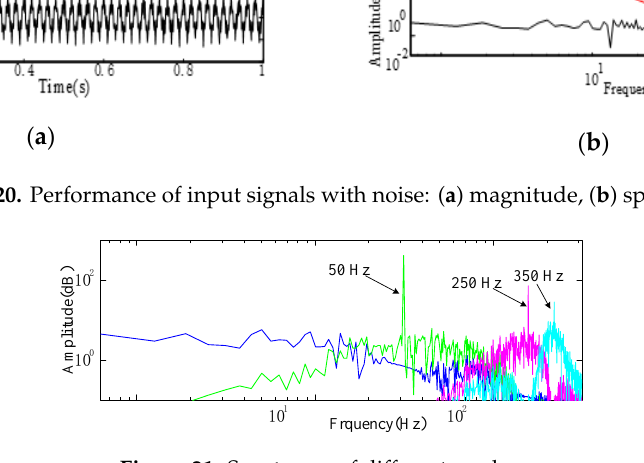
Figure 21. Spectrums of different modes. Table 5. Index of Orthogonality (IO) of VMD-HT algorithm decomposition under different K. Modes K =